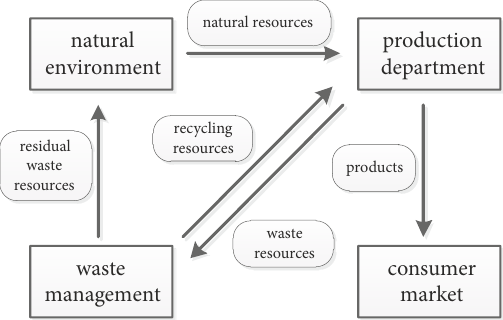
natural environment